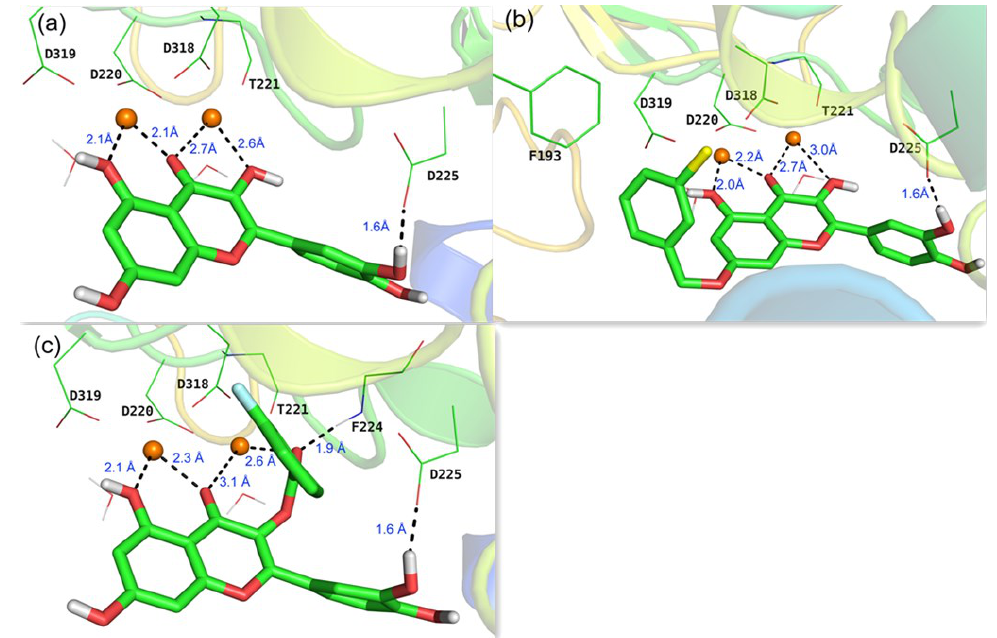
Figure 3. Predicted binding modes in the active site of a reported X-ray structure of HCV RdRp (PDB code: 1GX6 [22]) from docking studies: ( a ) quercetin 2 ; ( b ) compound 3i ; ( c ) compound 4f . The two Mg 2+ ions are indicated as orange spheres, carbon atoms are shown in green, oxygen in red, chlorine in yellow, and fluorine in